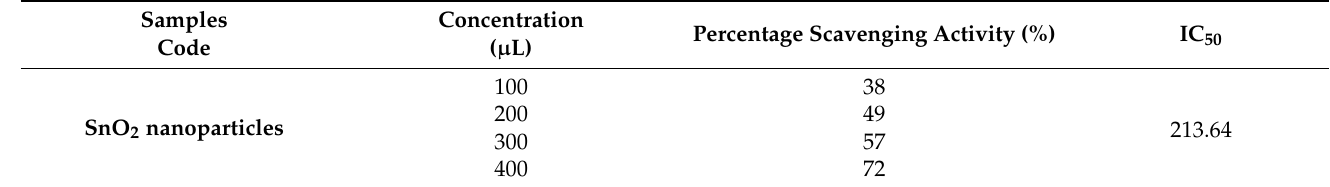
Figure 7. Antioxidant activity of SnO 2 nanoparticles against ABTS free radicals . Table 4 . Antioxidant activity values of different samples of SnO 2 nanoparticles . Table 4. Antioxidant activity values of different samples of SnO 2